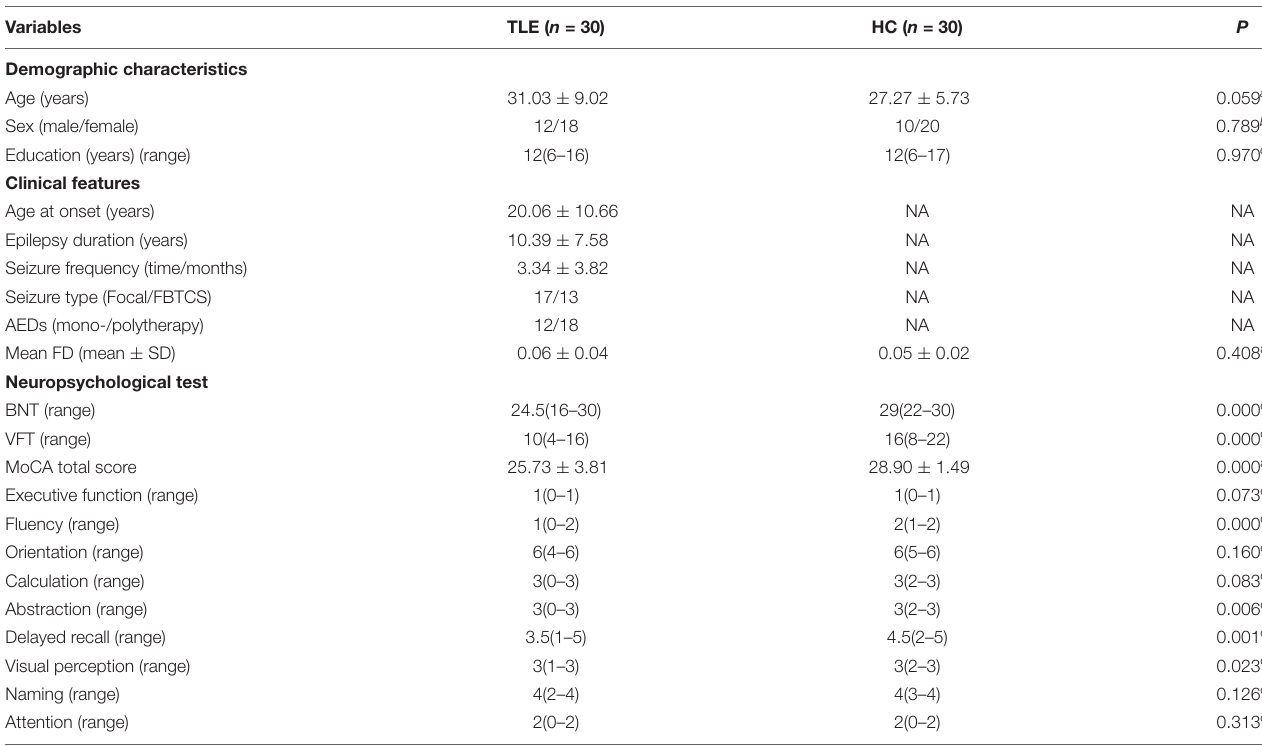
TABLE 1 | Demographics, clinical and neuropsychological parameters data of subjects in two